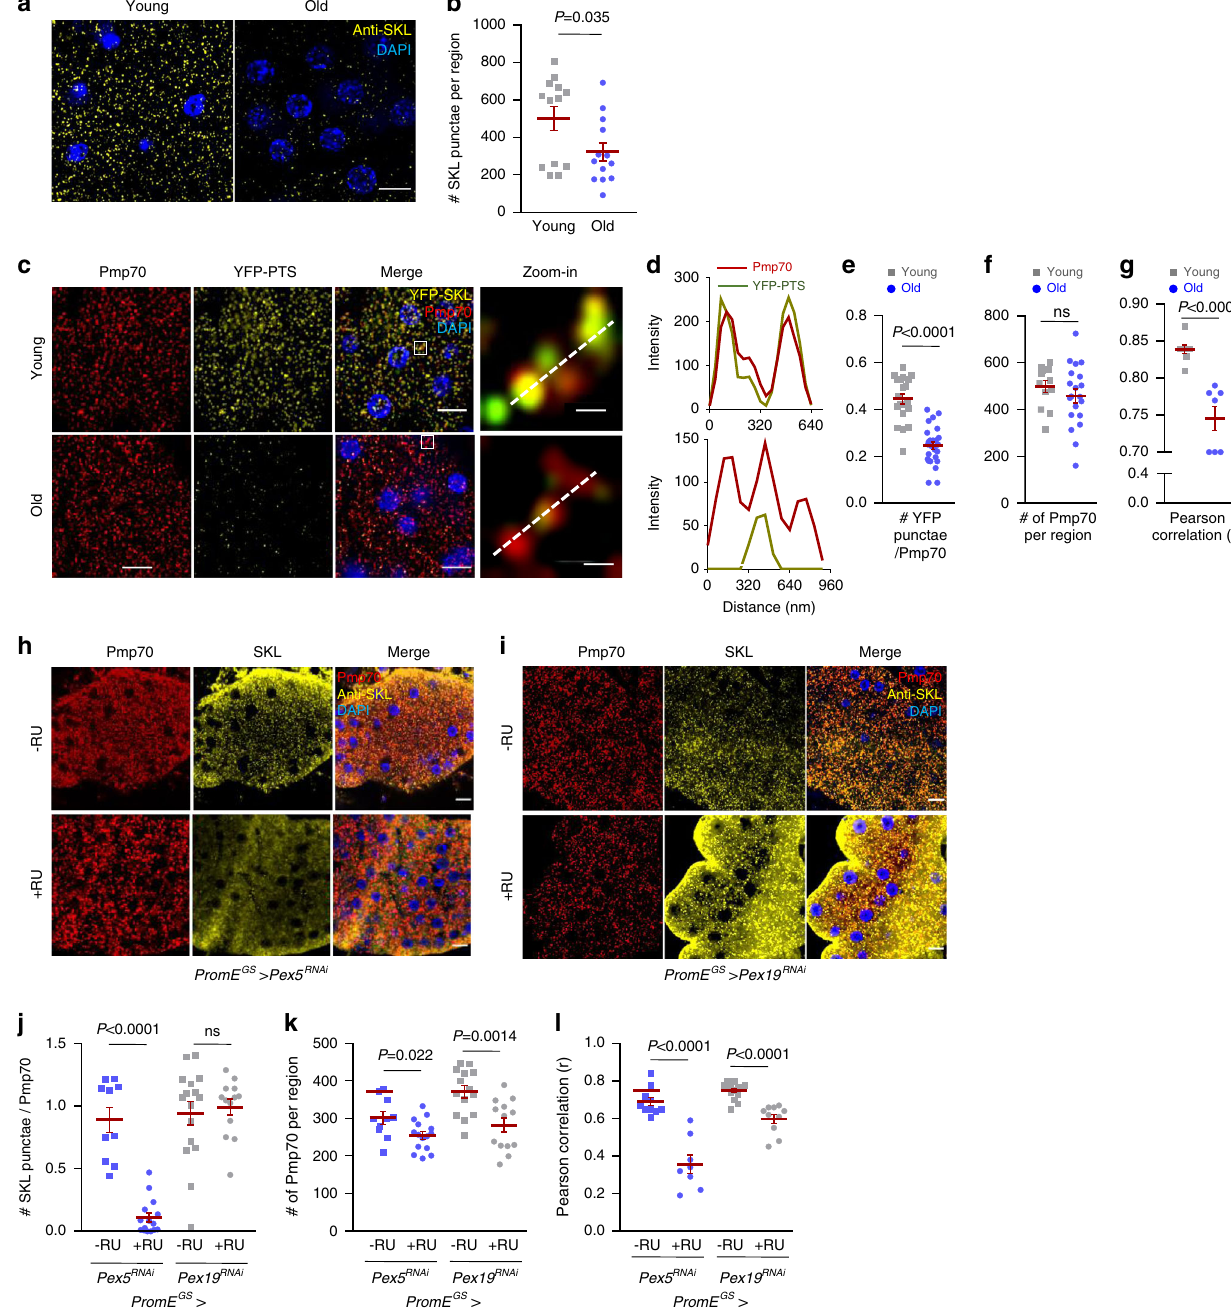
Fig. 6 Peroxisomal import function is disrupted in aged oenocytes. a Representative images of anti-SKL immunostaining of young and aged wild-type oenocytes. Scale bar: 6.7 µ m. b Quanti fi cation on the number of SKL-positive punctae in a . Dot plot shows the quanti fi cations of 6 biological replicates, 2 ROIs per replicate. c Representative images to show co-localization of Pmp70 and YFP-PTS in young and aged oenocytes (Scale bar: 6.7 µ m). Insets on the right show zoom-in peroxisome structures (the regions indicated by the white boxes in the merged panels, Scale bar: 125 nm). d Line scan analysis to show the fl uorescence intensity of Pmp70 (red) and YFP-PTS (green) crossing peroxisomes in the insets (dashed line). e Quanti fi cation of the number of YFP- positive punctae normalized Pmp70 in c . N = 6. Dot plot shows the quanti fi cations of 6 biological replicates, 4 ROIs per replicate. f Quanti fi cation of the number of Pmp70-positive punctae in c , N = 6 biological replicates, 4 ROIs per replicate. g Pearson correlation quanti fi cation measuring the correlation coef fi ciency of the co-localization between Pmp70 and YFP-PTS in c . N = 6 biological replicates. h Representative images of anti-SKL and anti- Pmp70 immunostaining of PromE GS > Pex5 RNAi oenocytes. Scale bar: 6.7 µ m. i Representative images of anti-SKL and anti-Pmp70 immunostaining of PromE GS > Pex19 RNAi oenocytes. Scale bar: 6.7 µ m. j Quanti fi cation of the number of SKL-positive punctae normalized Pmp70 in h , i . k Quanti fi cation of the number of Pmp70-positive punctae in h , i . l Quanti fi cation of Pearson correlation coef fi ciency of the co-localization between Pmp70 and SKL in h , i. 6 biological replicates, 3 ROIs per replicate. Data are represented as mean ± SEM. P values are calculated using two-sided unpaired t-test ( b , e – g ). or two- way ANOVA by Holm-Sidak multiple comparisons ( j – l ), ns: not signi fi cant. For speci fi c statistical number, please refer to the source